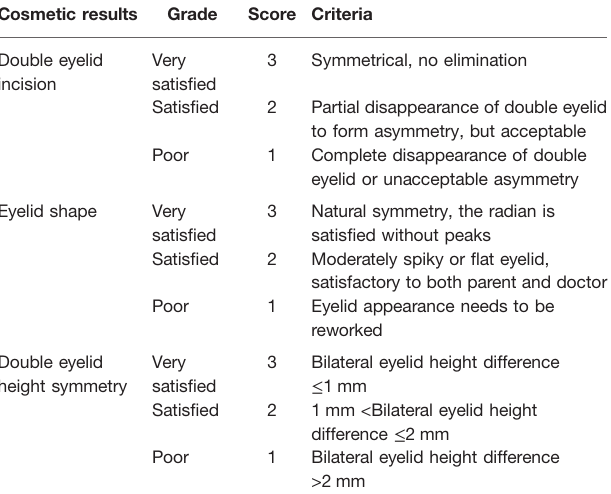
TABLE 3 | Cosmetic results evaluation